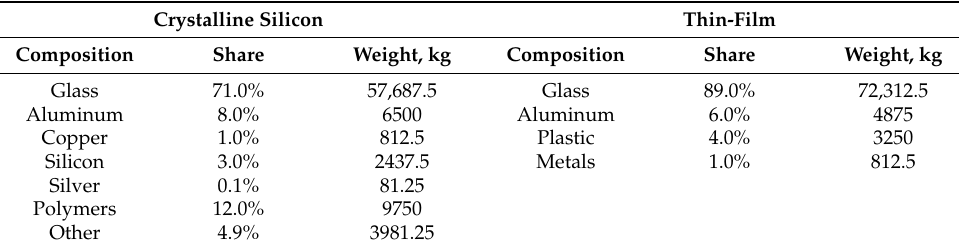
Table 1. Compositions of elements in 1-MW capacity solar